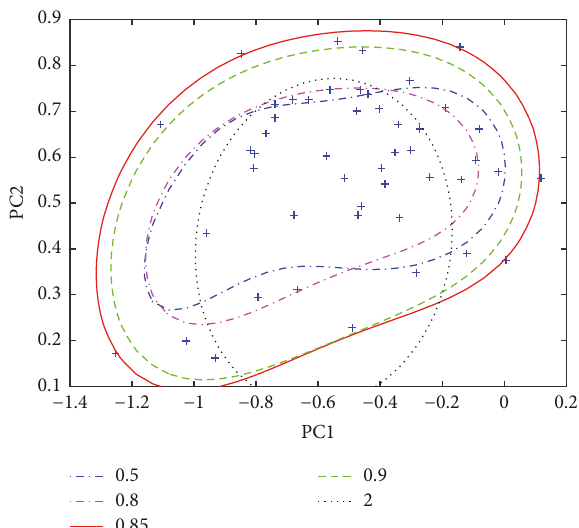
Figure 6: Ensemble of the influence of the kernel parameter on the boundary of support vector data description (SVDD) on the same